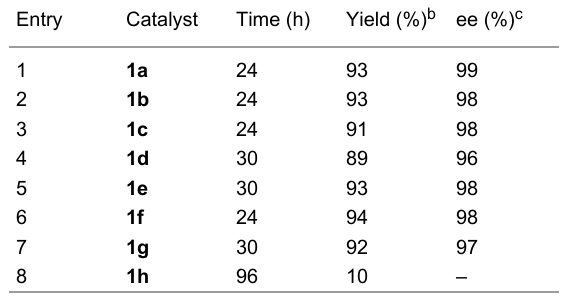
Table 4: Catalyst screening of the enantioselective Michael addition of acetone ( 2a ) to isatylidenemalononitrile ( 3a ). a